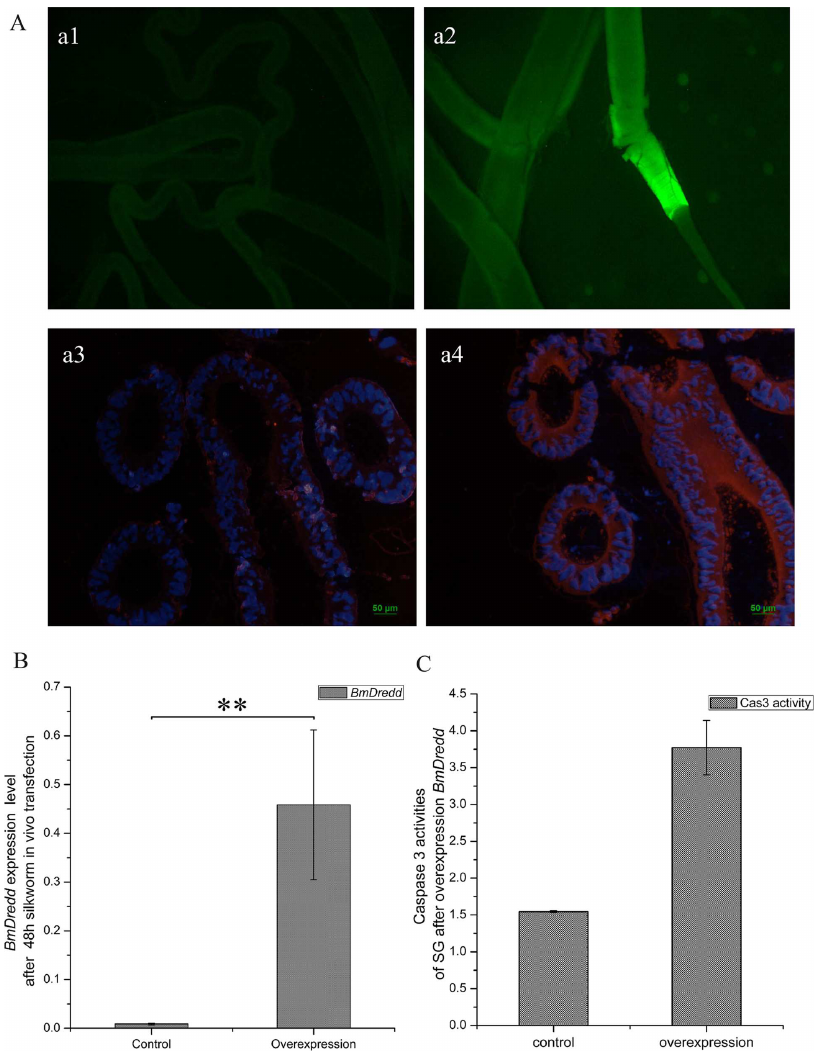
Fig 4. Overexpression of BmDredd in silkworm. (A) Fluorescence microscopy, a1 and a2: green fluorescence indicativeof successful transfection and overexpression of the PXL-BAC-U6-Dredd-GFP. a3 and a4: DAPI and Rhodaminestaining,DAPI (blue fluorescence): nuclei, Rhodamine(red fluorescence): Bm Dredd.a1, a3: control, a2, a4: overexpression of Bm Dredd.(B) BmDredd expressionlevels in the SG after 48h overexpression. P < 0.01. (C) caspase3-like activity of SG after 48 h